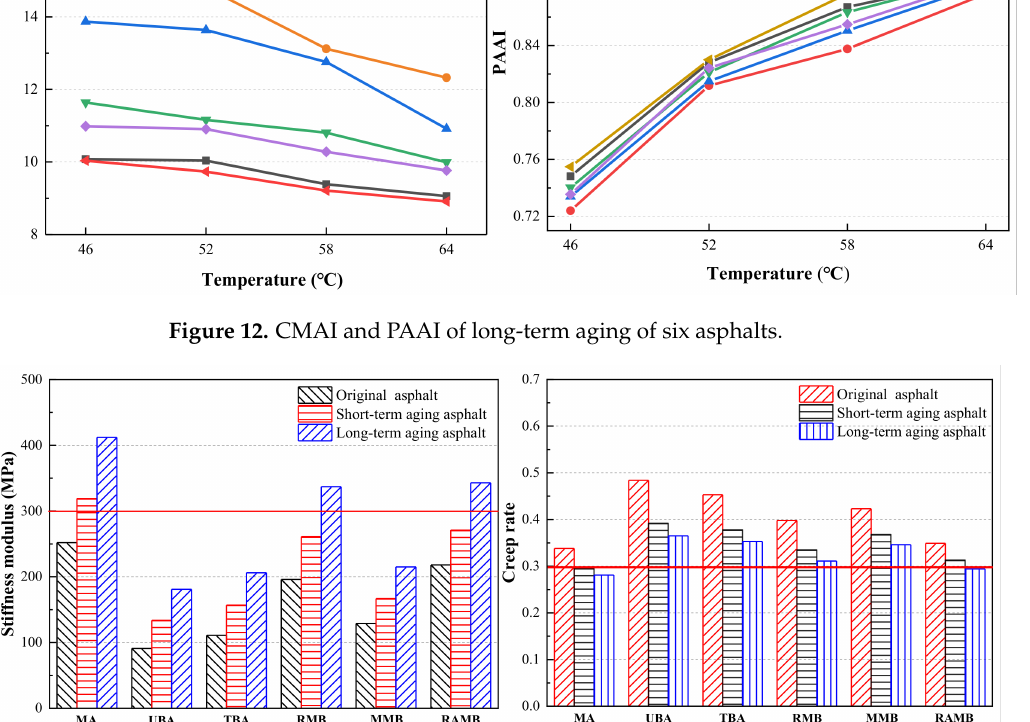
Figure 13. The S and m values of six asphalts in different aging